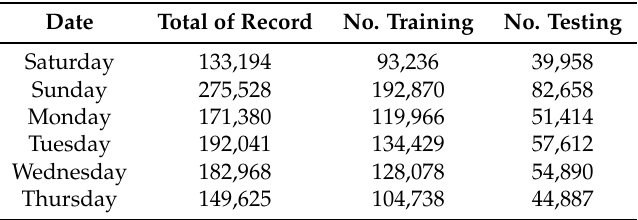
Table 1. List of number of record for training and testing